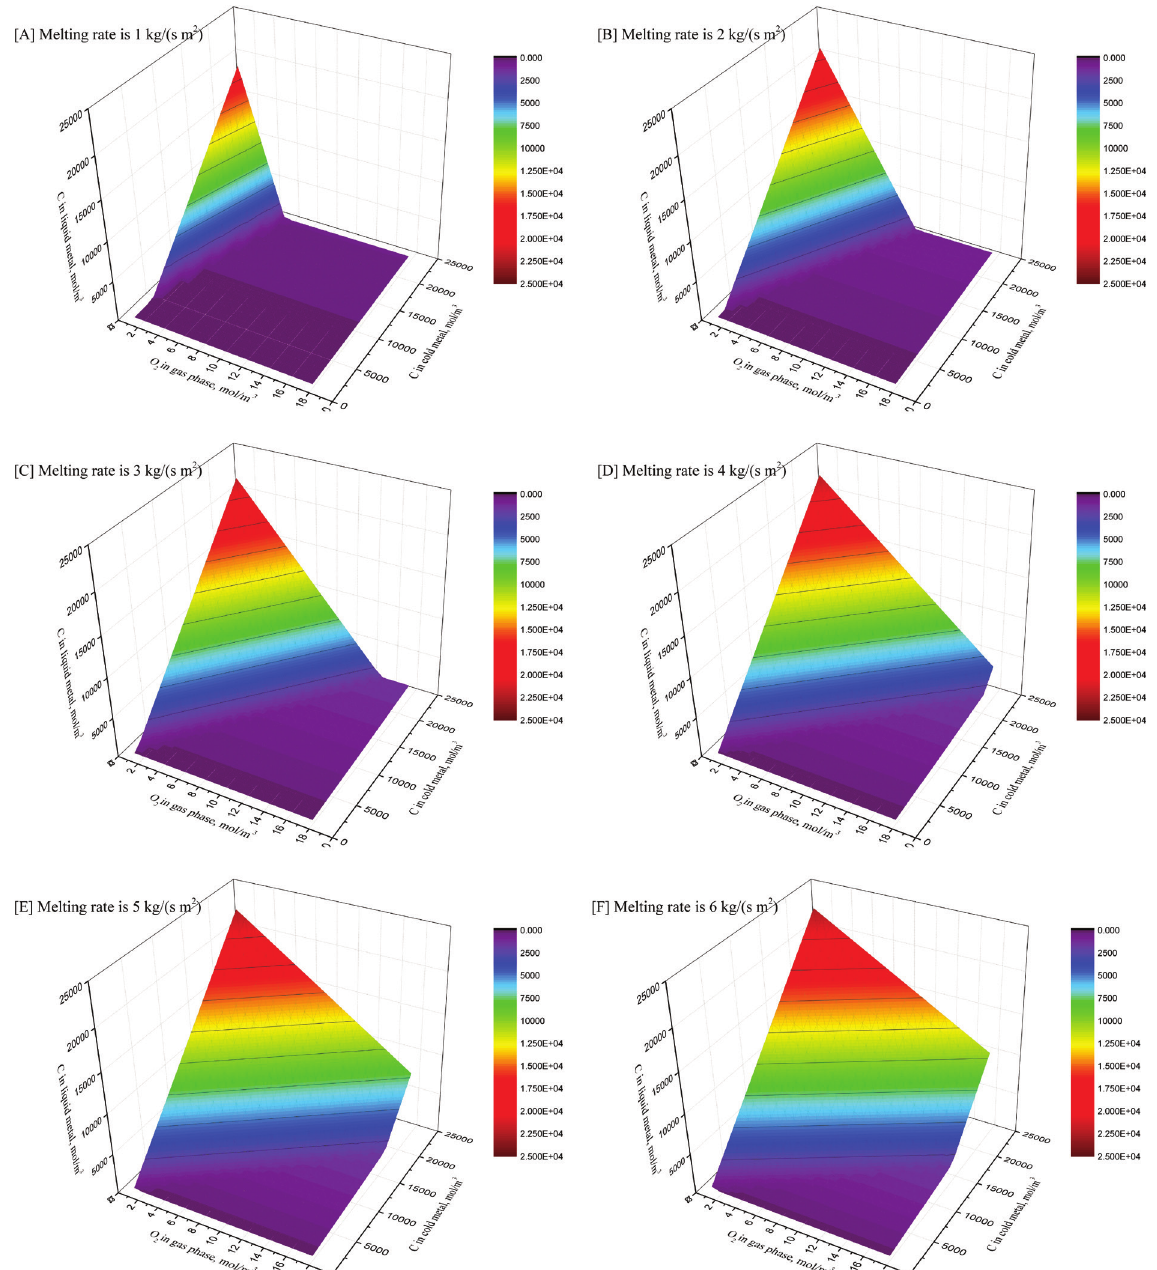
Fig. 6: Relationships between concentrations of C in liquid metal and concentrations of O 2 in gas phase and C in solid metal at different melting